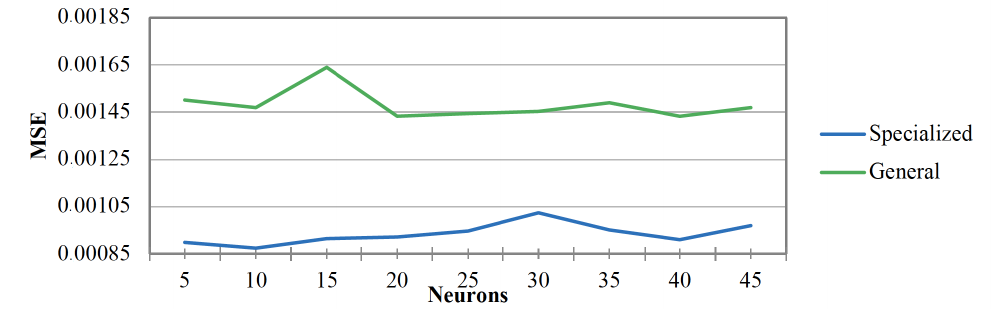
Figure 7. Evolution of the error with respect to the number of neurons for the general model ( green ) and for the specialized models ( blue